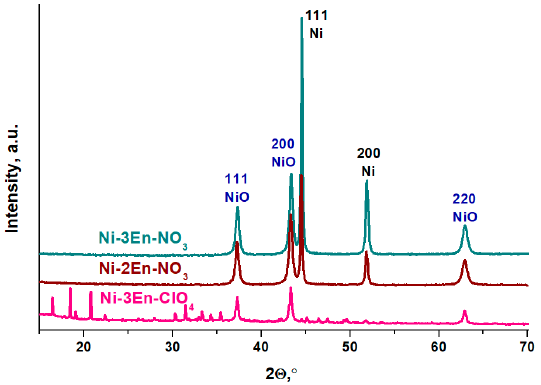
Figure 6. The XRD patterns of Ni-2En-NO 3 , Ni-3En-NO 3 and Ni-3En-ClO 4 samples.